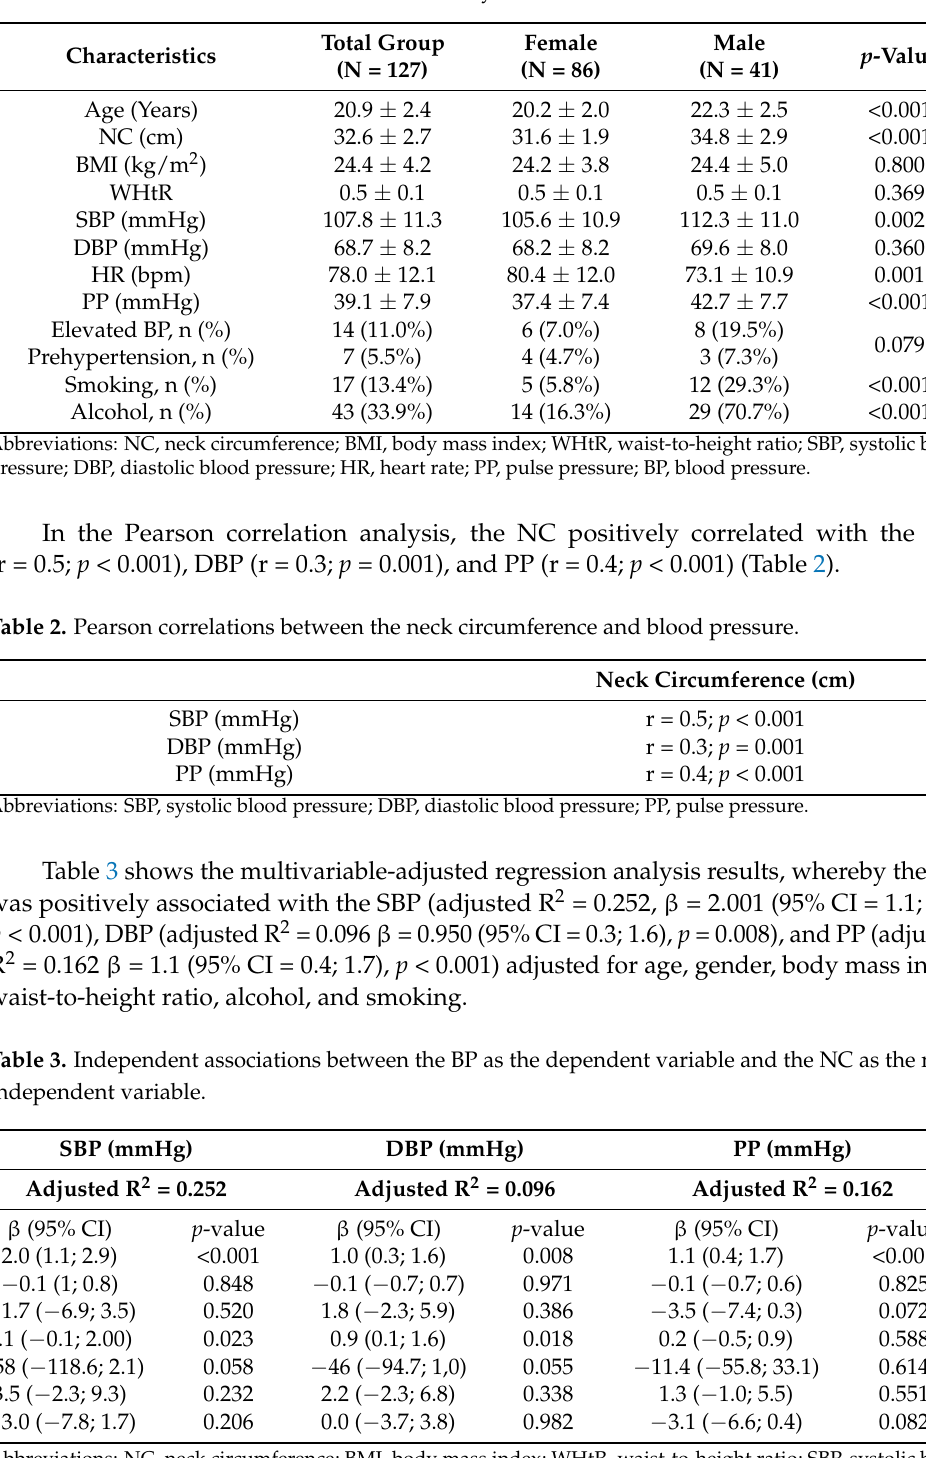
Table 1. Characteristics of Walter Sisulu University students.